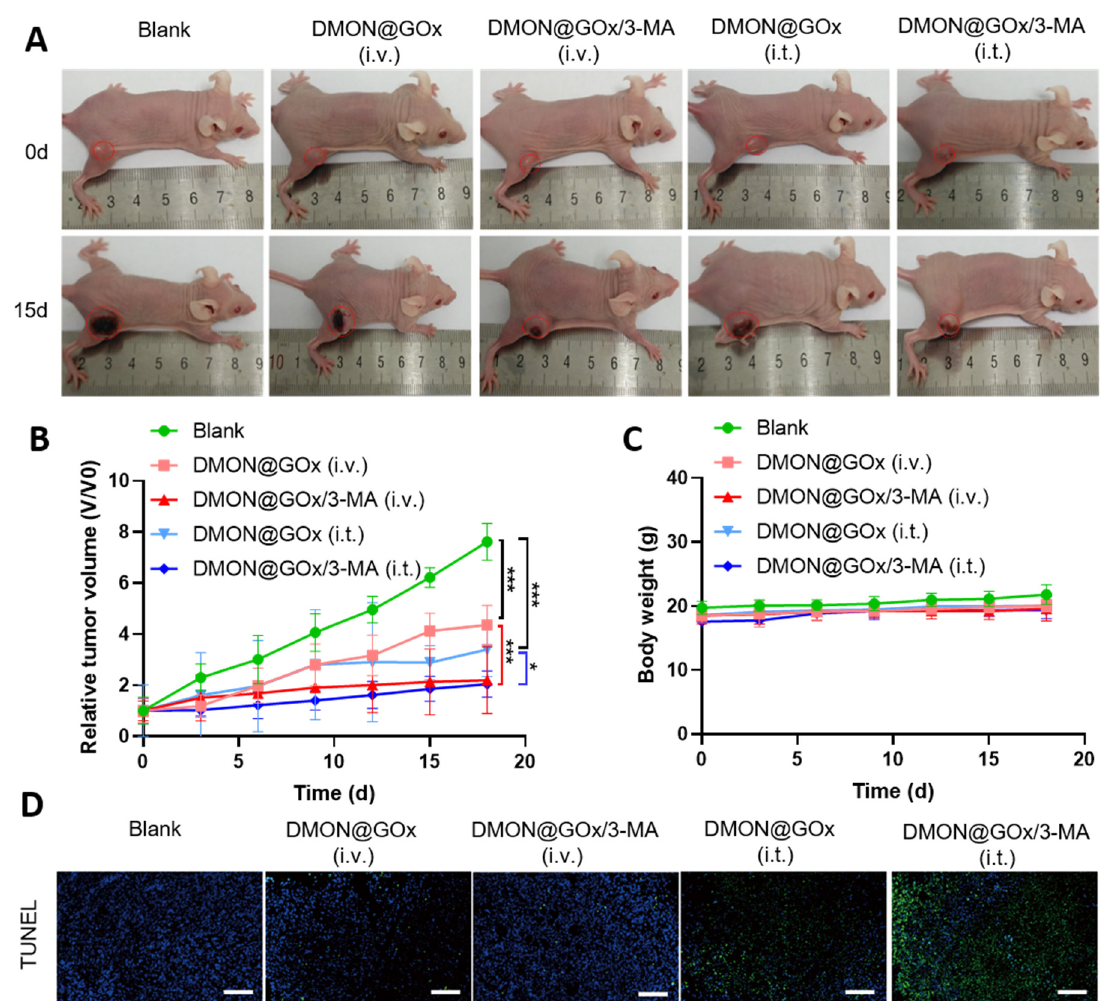
Figure 4. In vivo bioactivity of DMON@GOx/3-MA. ( A ) Digital pictures of tumors from the 4T1 tumor-bearing nude mice i.v. or i.t. injected with DMON@GOx or DMON@GOx/3-MA. ( B ) Tumor growth curves of 4T1 tumor-bearing nude mice treated as in ( A ). ( C ) Body weight of the mice treated as in ( A ). ( D ) TUNEL staining of tumor sections from the 4T1 tumor-bearing mice. Scale bar: 100 μ m. * p < 0.1, *** p < 0.001, p value was analysed by two-way ANOVA. Data are the means ± s.d.